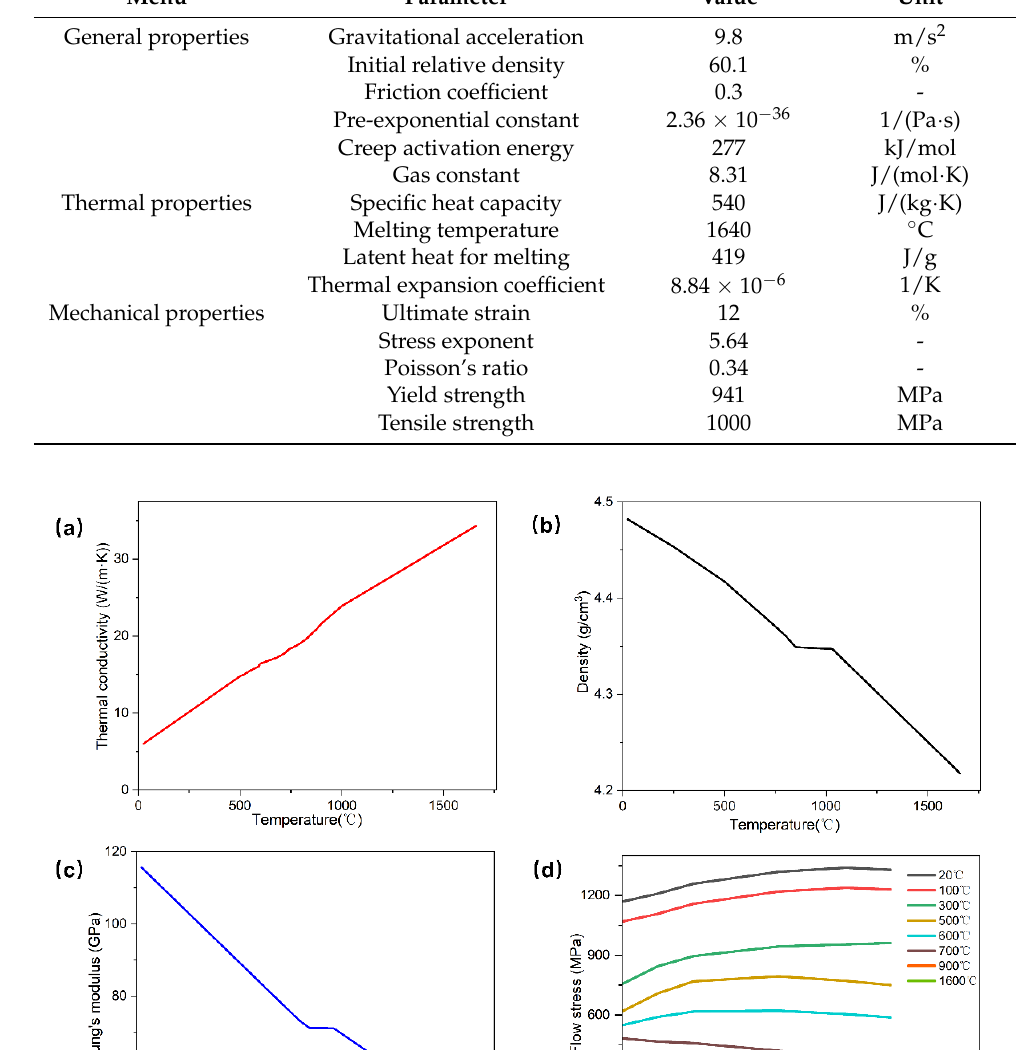
Table 1. Materials parameters for Ti-6Al-4V used in the simulation.